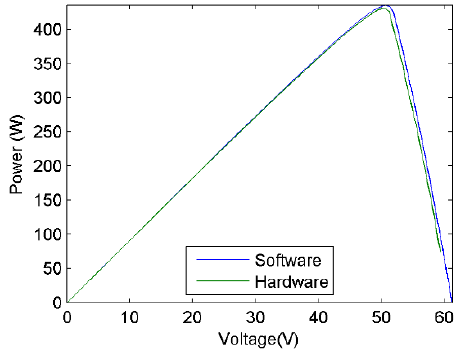
Figure 19. P-V curve of the PVPE.